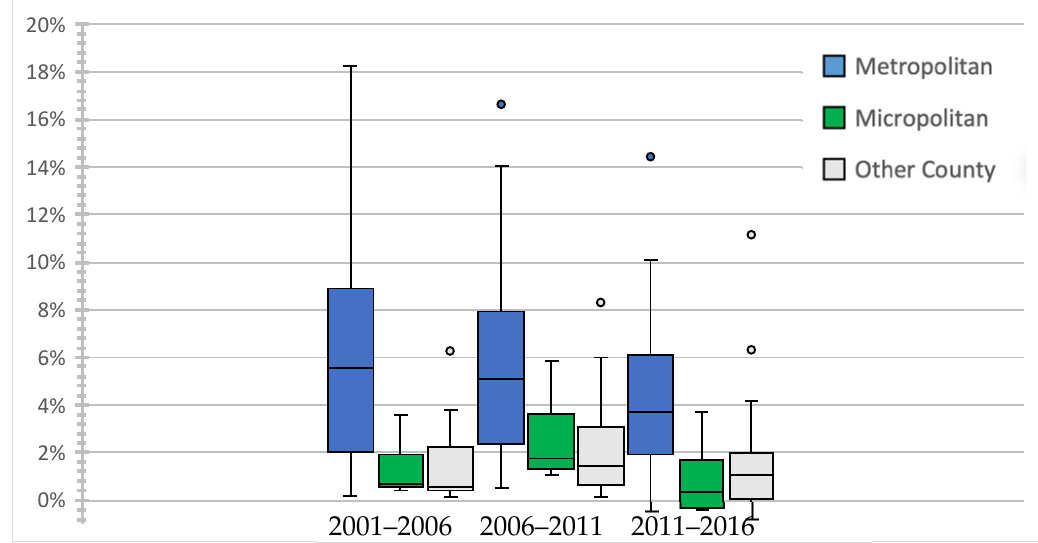
Figure 5. Urbanized land growth rate in different geographic area in the Texas Triangle.